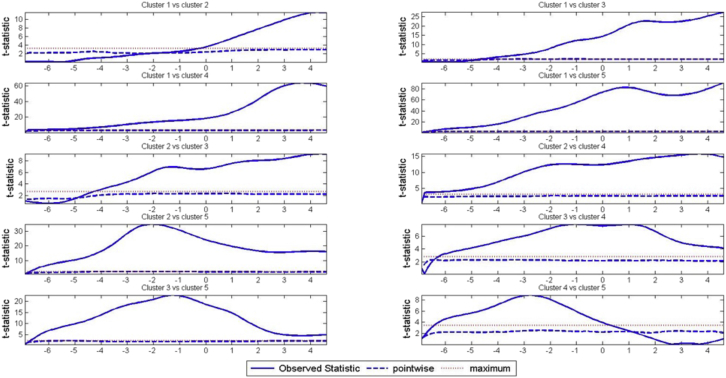
Functional t test for differences between responses in the 5 clusters.